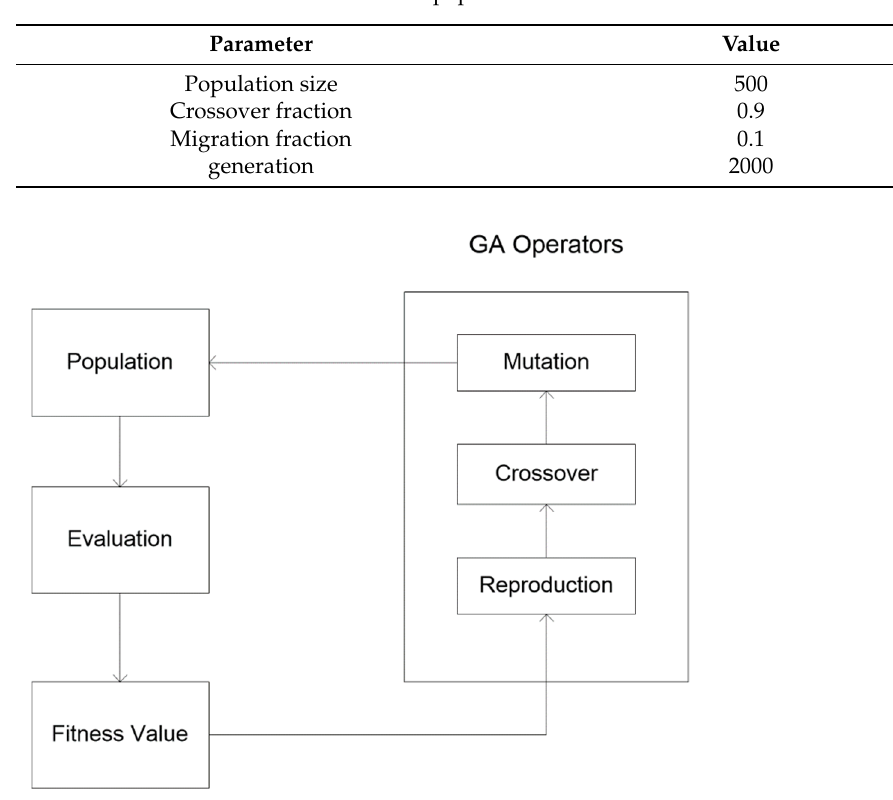
Figure 5. Flow Chart of Greedy Rules. Table 2. Parameters of GA method in this paper.